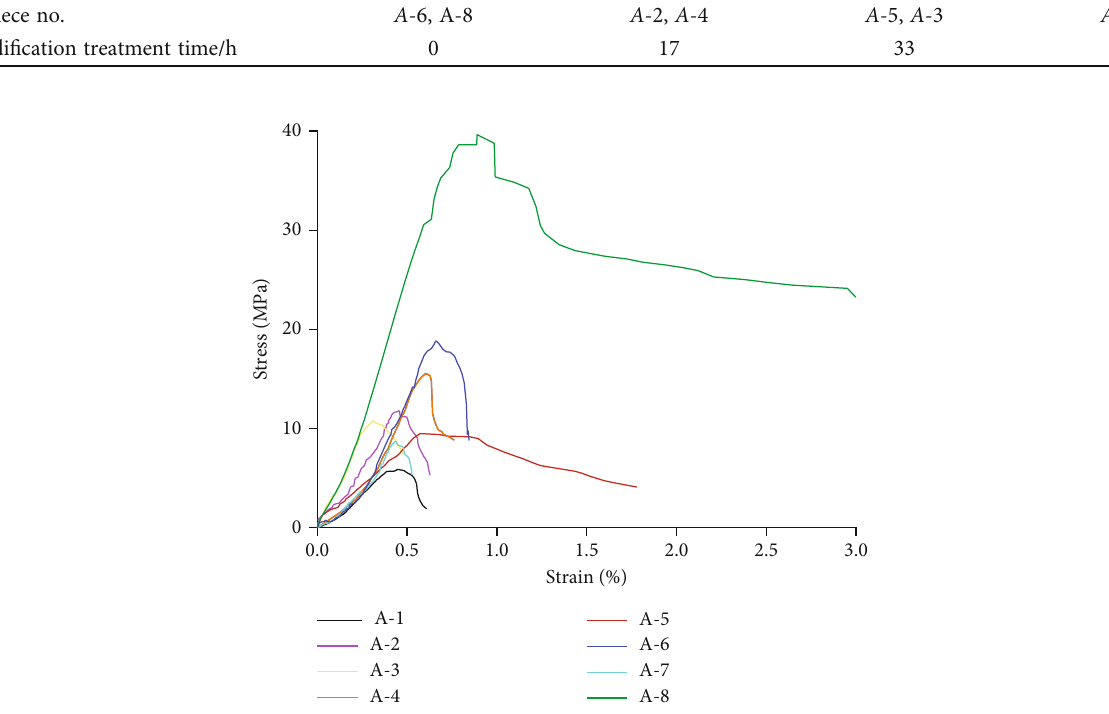
Figure 1: Axial stress-axial strain